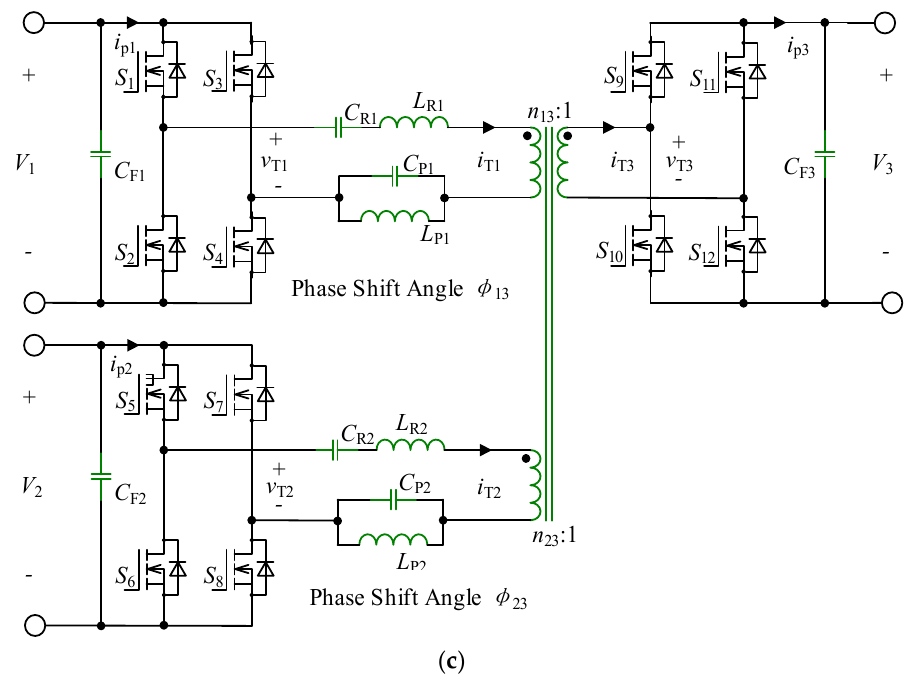
Figure 2. The structures of TP-BDC ( a ) TAB; ( b ) SR-TBC; ( c ) MR-TBC.